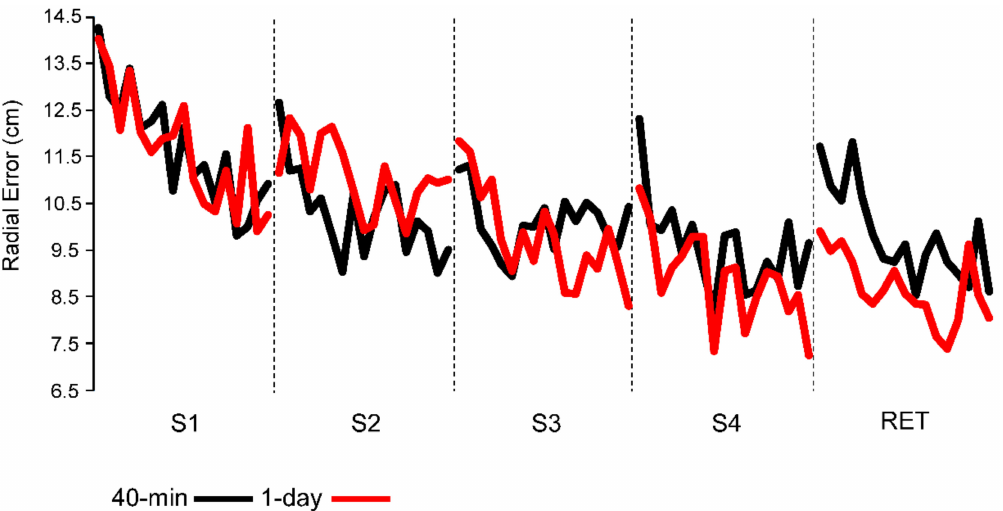
Figure 3. Changes in radial error ( R E ) within the sessions. The performance within single session is represented by 17 data points, each summarizing the grand average computed over eight blocks, one for each participant (one block = 15 throws). Abbreviations and labels are the same as in Figure